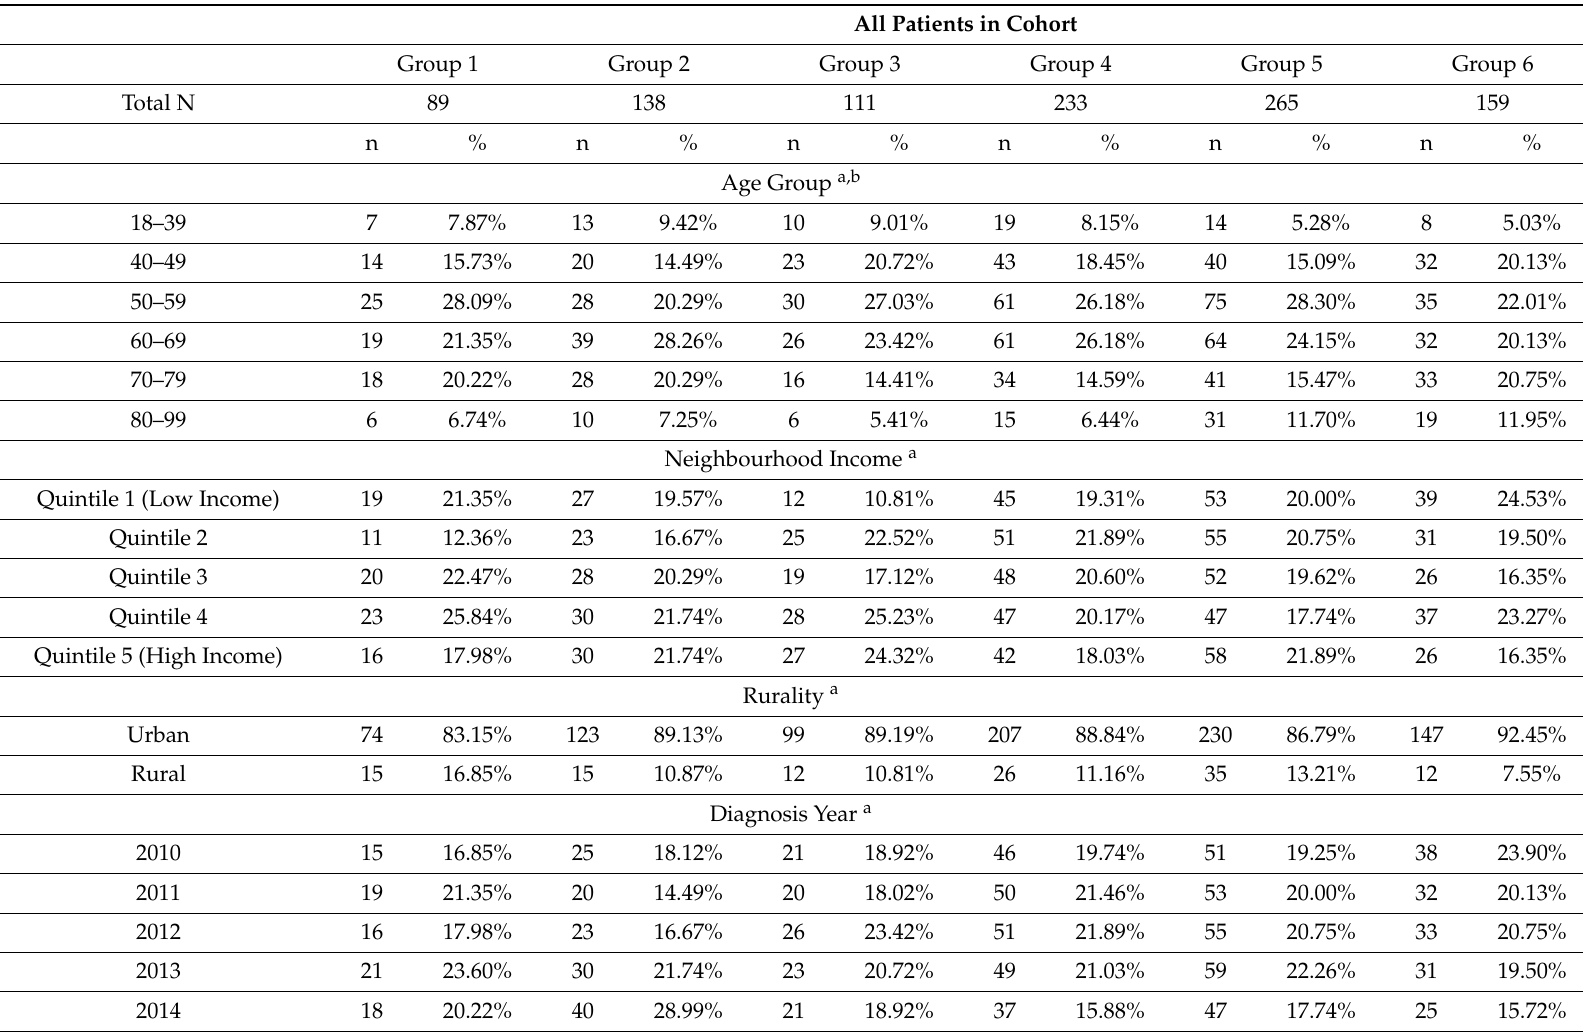
Table 3. Patient characteristics by trajectory group